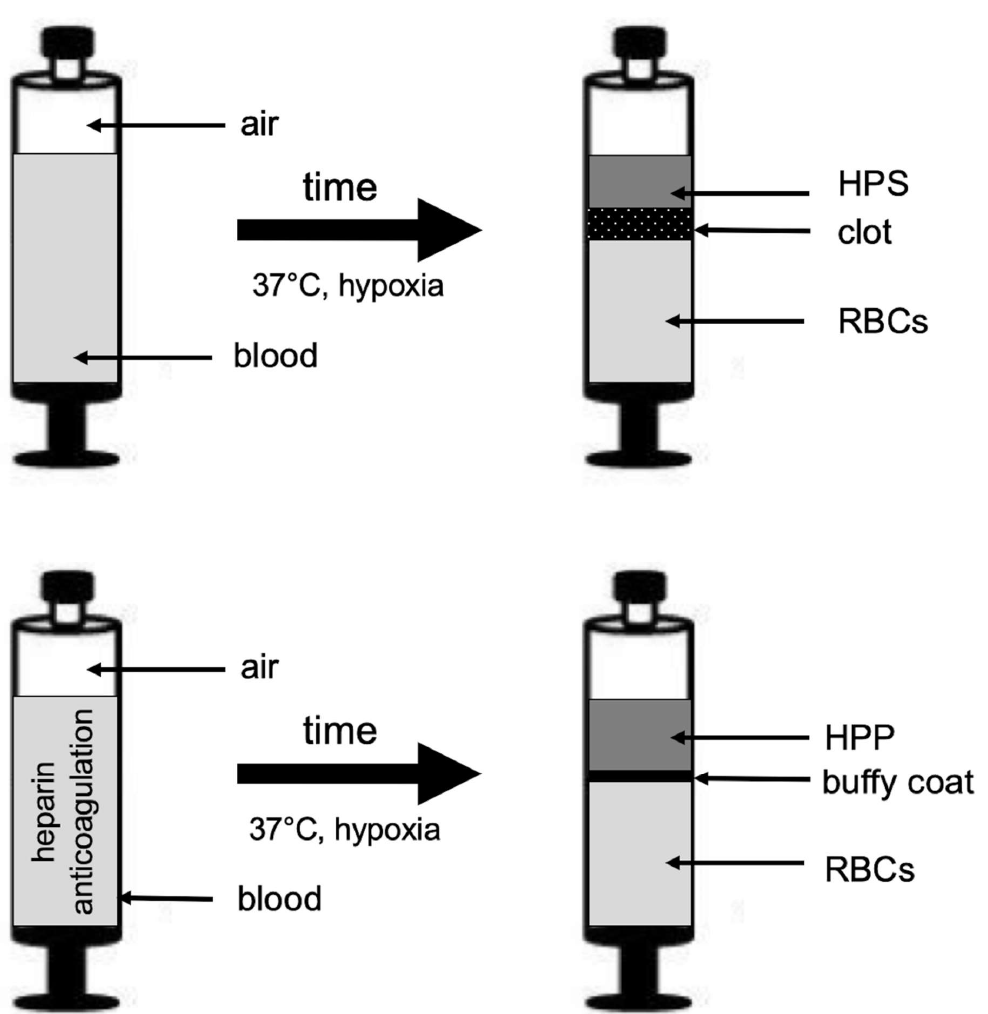
Figure 1. Method of preparation of hypoxia preconditioned plasma and serum (HPP and HPS). Peripheral venous blood obtained from subjects that received no oral anticoagulation (OA) or were on treatment with oral anticoagulants (acetylsalicylic acid (ASA), ASA + clopidogrel, or nonvitamin K antagonist oral anticoagulants (NOACs)) was allowed to clot (upper schematic) or additionally anticoagulated with heparin (bottom schematic) for HPS and HPP preparation, respectively. Peripheral blood cells (in clot or buffy coat) were conditioned under pericellular (local) hypoxia (~1% O 2 ) and physiological temperature (37°C) for 4 days. Sedimentation passively separated growth factor-rich HPS and HPP from clot and buffy coat, respectively, while red blood cells (RBCs) collected at the bottom of the chamber.